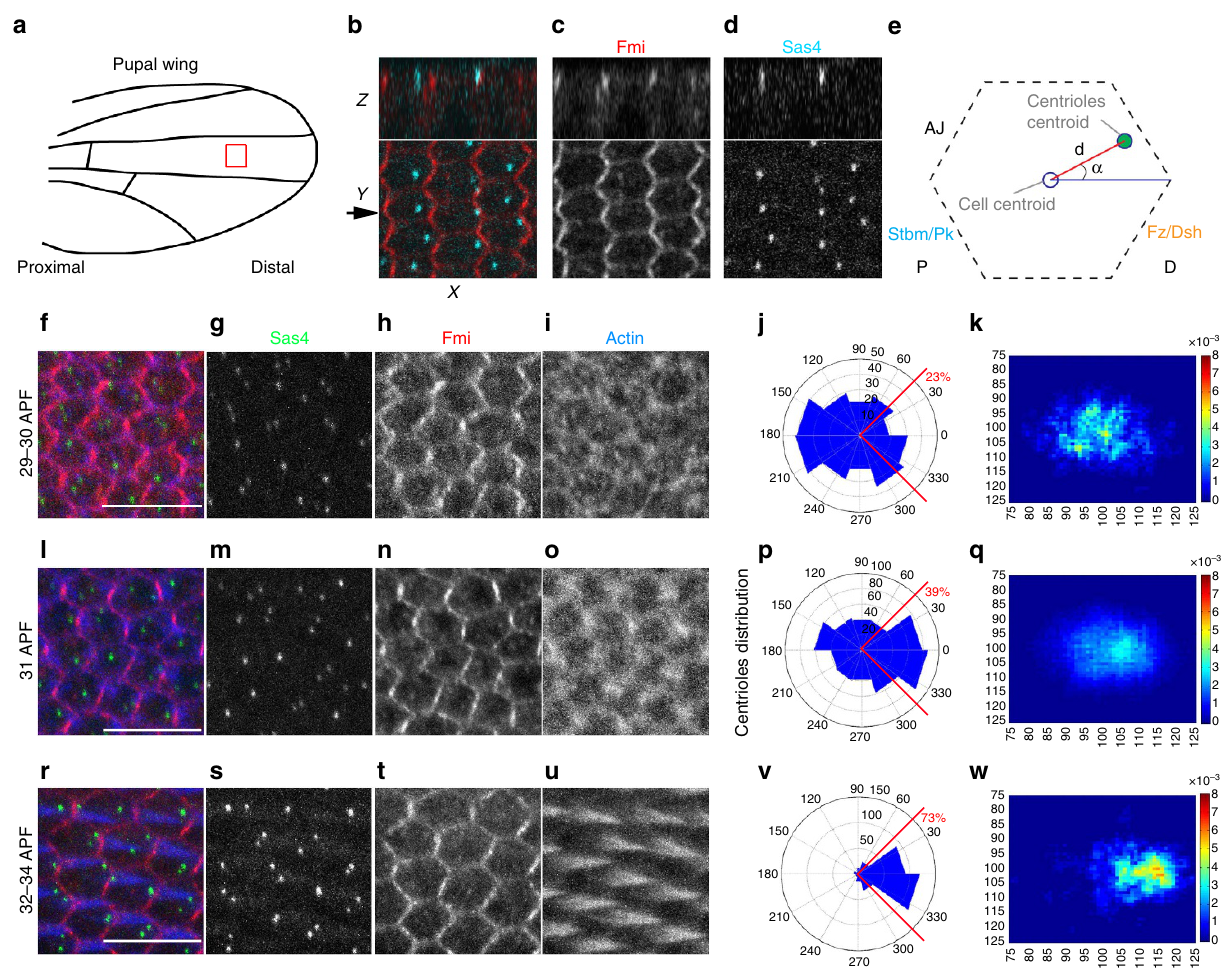
Figure 1 | Centriole localization and positioning during PCP establishment in pupal wings. ( a ) Illustration of pupal wing and its orientation ( b – d ) Sas4-labelled centrioles (cyan in b and monochrome d ) are distributed in the junctional planes ( X – Z plane—upper panels) (marked by Fmi staining, red in b , monochrome in c ). Top panels are x – z sections of respective x – y views shown below. Scale bar, 10mm. ( e ) Schematic representation of a pupal wing epithelial cell and the parameters used to study centriole positioning. ( f – w ) During pupal wing development, centriole localization changes. ( f , l , r ) Sas4 (green), Fmi stained in red, and actin (phalloidin) in blue, and the respective monochromes. ( f – k ) Before hair formation (29h APF), centrioles are unpolarized in a central position in the apical portion of each cell (quantified in f , k ). ( l – q ) At the onset of hair formation (31h APF), centrioles begin to localize to the distal portion of each cell (quantified in p , q ). ( r – w ) Subsequently, when hairs are fully present in all wing cells (32–34h APF), centrioles appear to be polarized mostly to the distal sector of each cell (quantified in v , w ). Scale bar, 10mm. Red sectors in f , p , v —% within distal quadrant.